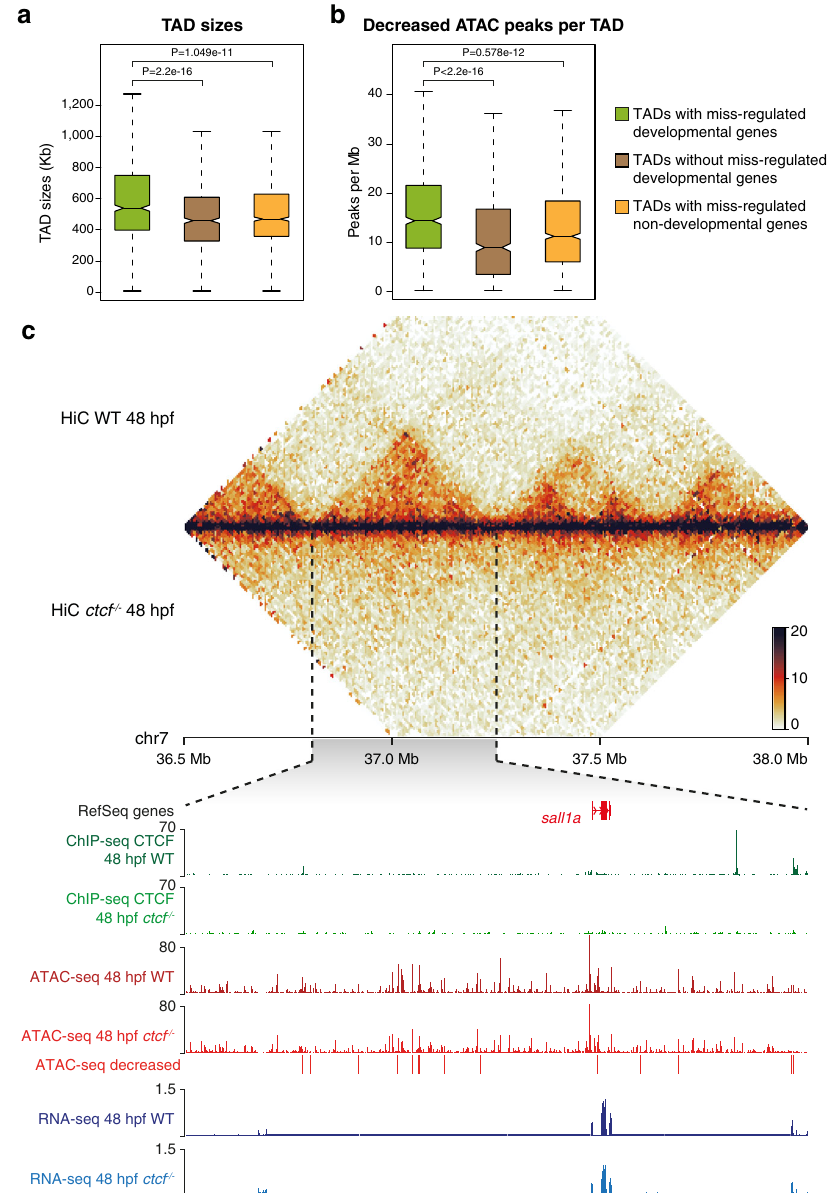
Fig. 5 Clusters of cis -regulatory elements around developmental genes lose accessibility upon CTCF loss. a , b Box plots showing the TAD sizes (h) and the number of decreased DARs per Mb (i) for TADs containing developmental miss-regulated genes, TADs not containing developmental miss-regulated genes, and TADs containing only non-developmental miss-regulated genes. Boxplots represent the centerline, median; box limits, upper and lower quartiles; whiskers, 1.5× interquartile range; notches, 95% con fi dence interval of the median. Statistical signi fi cance was assessed using a two-sided Wilcoxon ’ s rank-sum test. c Top, heatmaps showing HiC signal in WT and ctcf − / − embryos at 48 hpf in a 1.5-Mb region of chromosome 7. Bottom, zoom within the sall1a TAD showing tracks with CTCF ChIP-seq, ATAC-seq, and RNA-seq at 48 hpf in WT and ctcf − / − embryos, as well as decreased ATAC-seq peaks. The downregulated sall1a gene is shown in